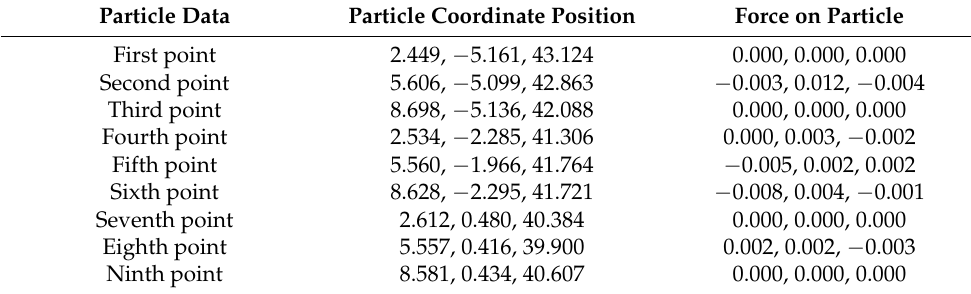
Table 4. Position and force of particles in the model under a balanced stress state. Particle Data